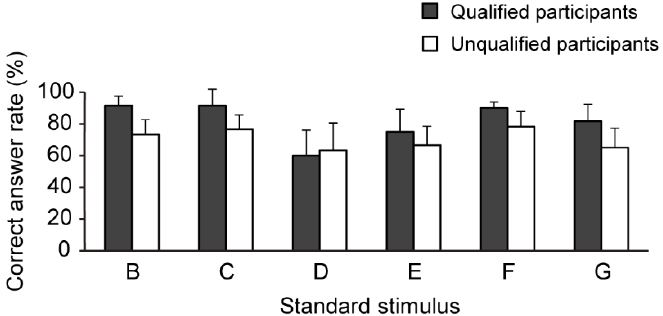
Figure 5. Correct answer rates for each standard stimulus.